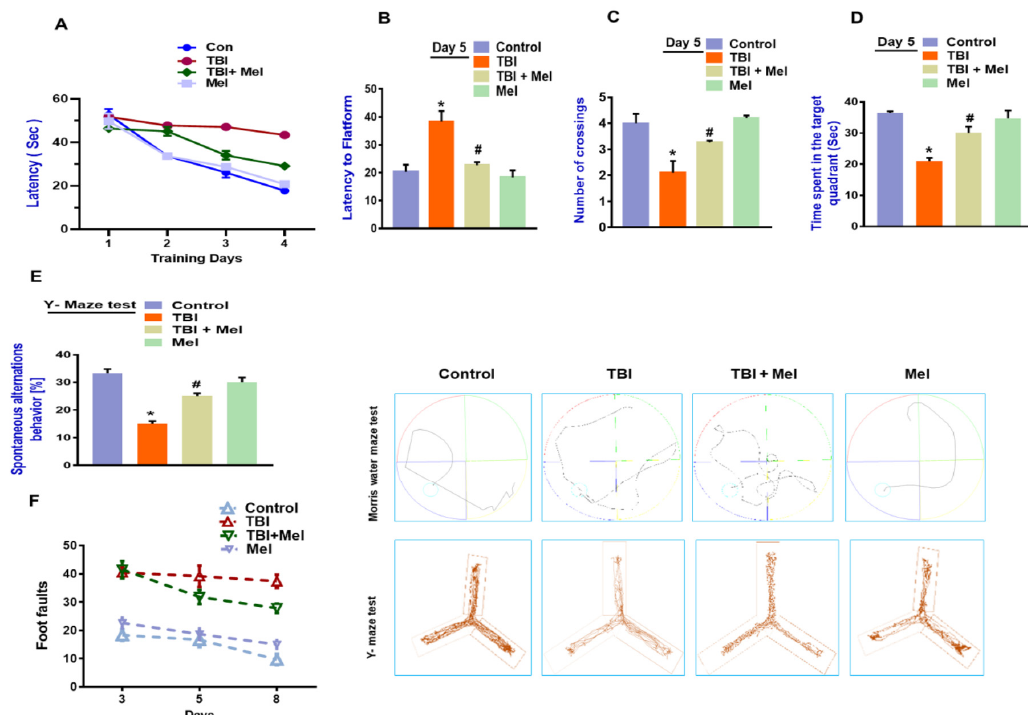
Figure 8. Melatonin improved hippocampal ‐ dependent memory impairment in the mouse model of traumatic brain injury (TBI). ( A ) Representation of the escape latency during training days. ( B ) Histogram showing the escape latency during the probe test. ( C ) Histogram showing the number of crossings during the probe test. ( D ) The histogram represents the time spent in the target quadrant. ( E ) Histogram showing the spontaneous alternations behavior percentage (%) in the y ‐ maze test. n = 15 mice per group. ( F ). Representative histogram showing the number of foot faults in the treated group. The values are expressed as mean ± SEM. The differences have been shown in the graphs. The values are expressed as mean ± standard deviation: One ‐ way ANOVA followed by post ‐ hoc analysis. * p < 0.05 and ** p < 0.01 represent difference between control and repetitive mild traumatic brain injury (rmTBI), and # p < 0.05 and ## p < 0.01 represent difference between rmTBI plus melatonin (Mel) ‐ treated group.